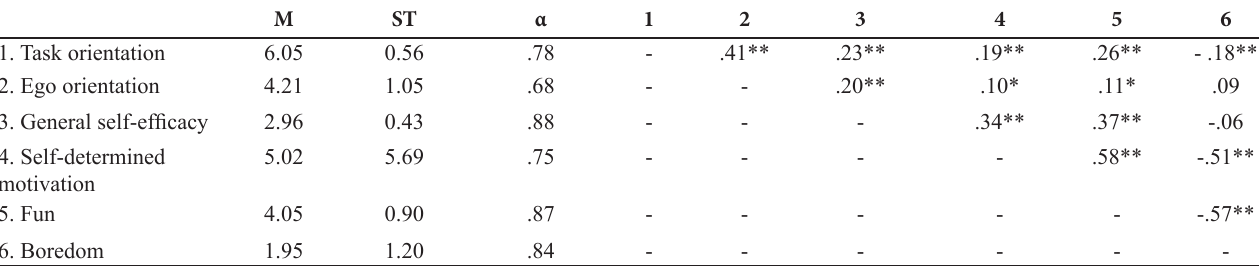
Table 1. Descriptives and correlations among study